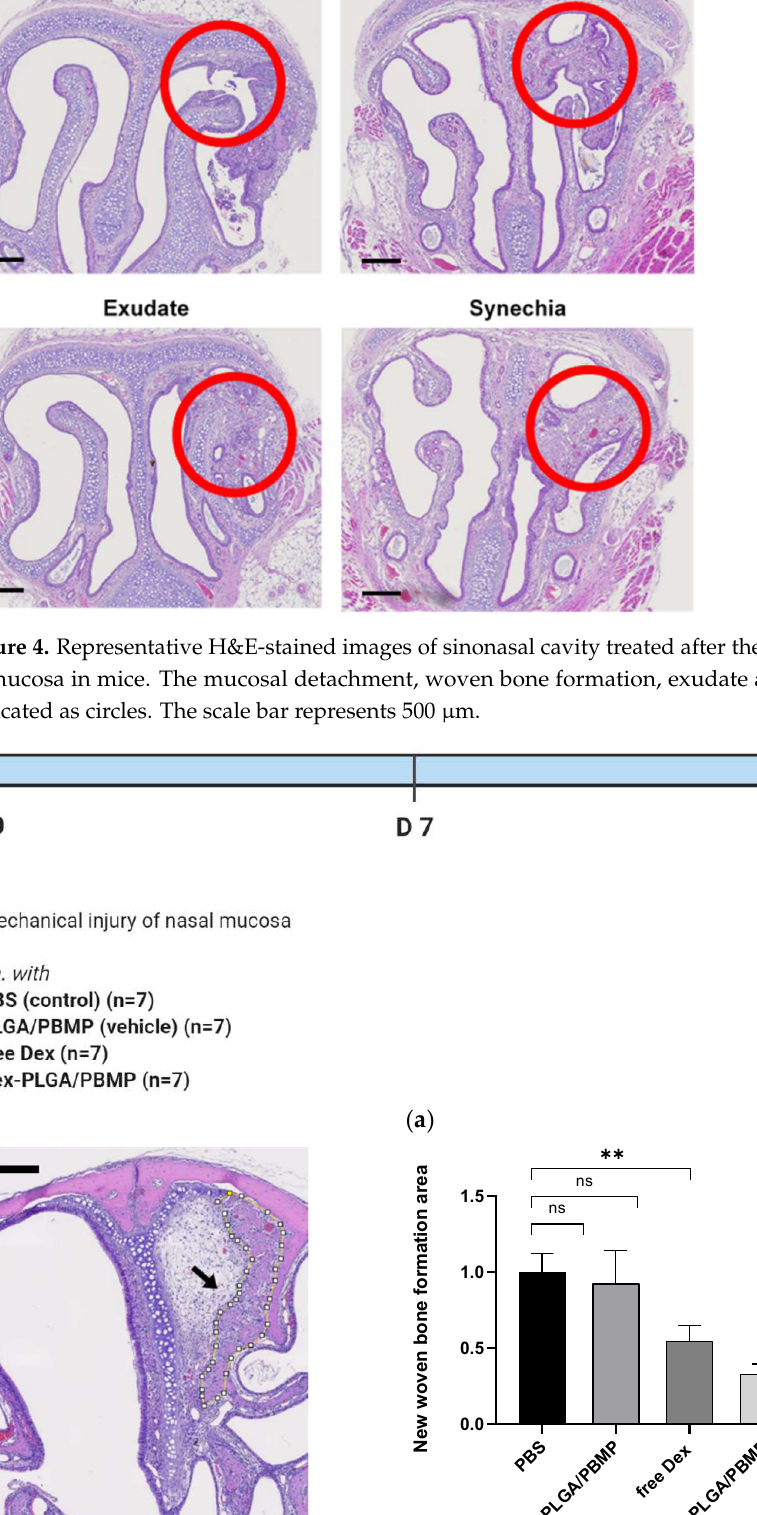
Figure 4. Representative H&E-stained images of sinonasal cavity treated after the mechanical injury of mucosa in mice. The mucosal detachment, woven bone formation, exudate and synechia were indicated as circles. The scale bar represents 500 μm.